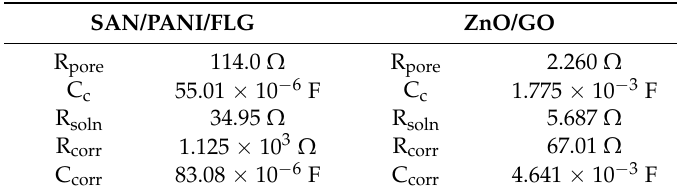
Table 7. Reap2cpe fitting values of coated samples in produced